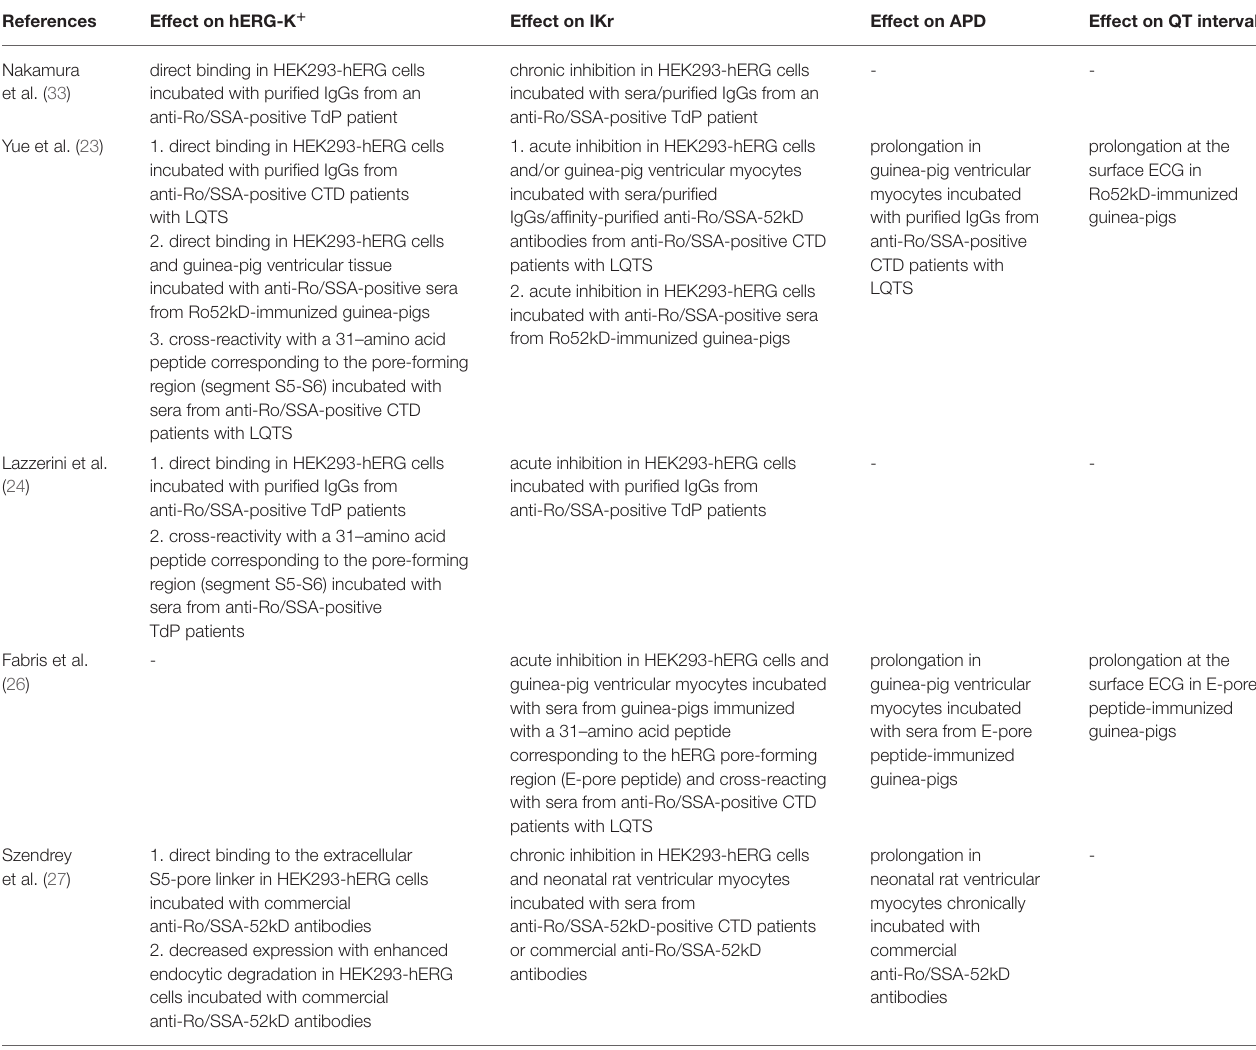
TABLE 2 | Basic mechanisms of anti-Ro/SSA-associated LQTS: data from experimental